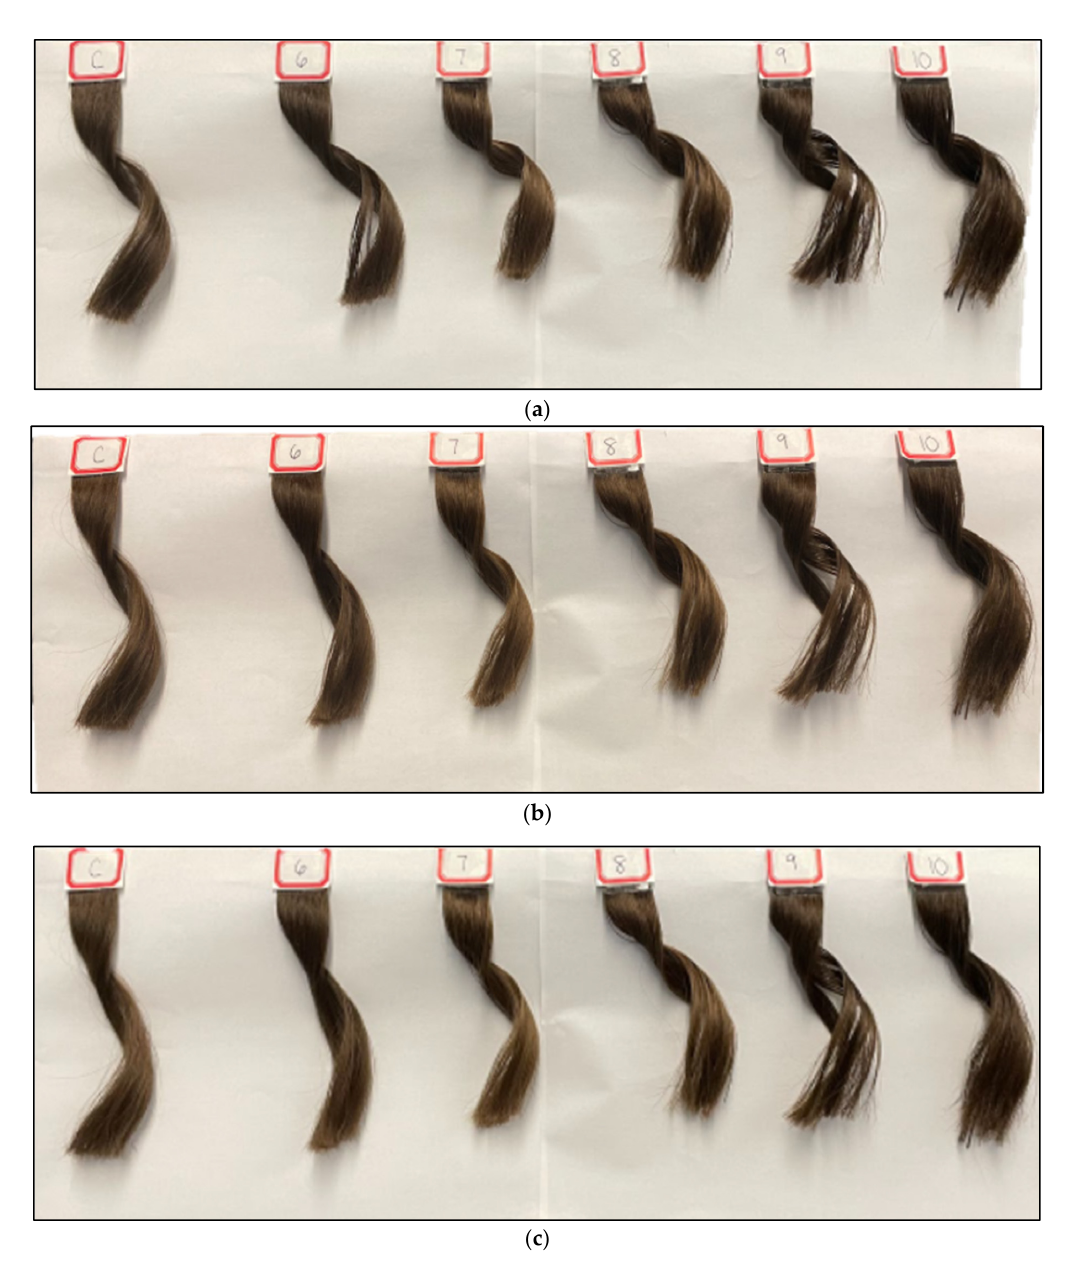
Figure 7. ( a ): Control piece of hair (far left) next to Samples 6 (next to control) through 10 (far right) curl drop test. Photo was taken at 0 h right after gel application. ( b ): Control piece of hair (far left) next to Samples 6 (next to control) through 10 (far right) curl drop test. Photo was taken 24 h after gel application. ( c ): Control piece of hair (far left) next to Samples 6 (next to control) through 10 (far right) curl drop test. Photo was taken 48 h after gel application.